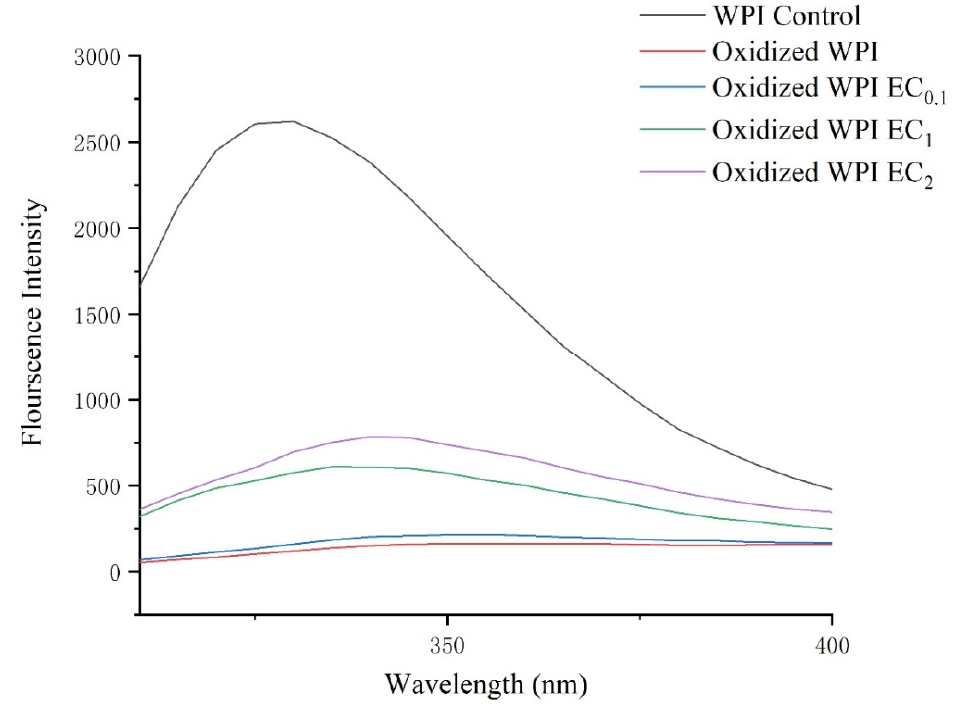
Figure 2. Spectrum of endogenous fluorescence changes in WPI. The fluorescence intensity was record at the excitation wavelength of 295 nm, and emission wavelength ranged from 315 nm to 400 nm.